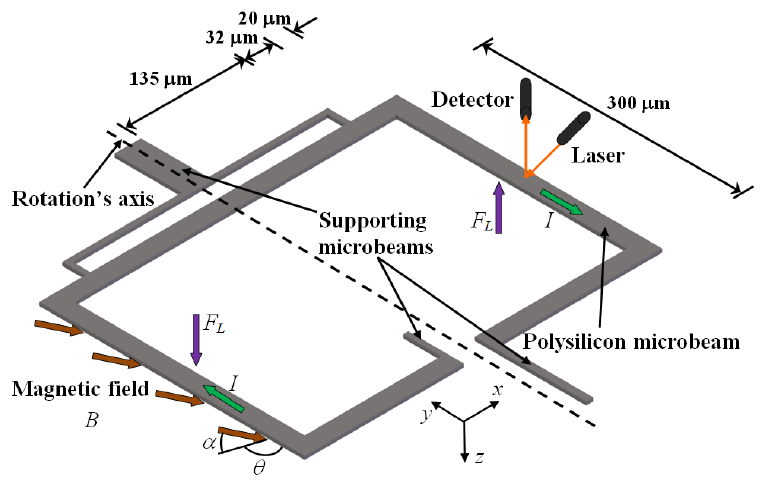
Figure 11. Schematic view of the magnetic field sensor based on resonant polysilicon beams reported by Herrera-May et al .